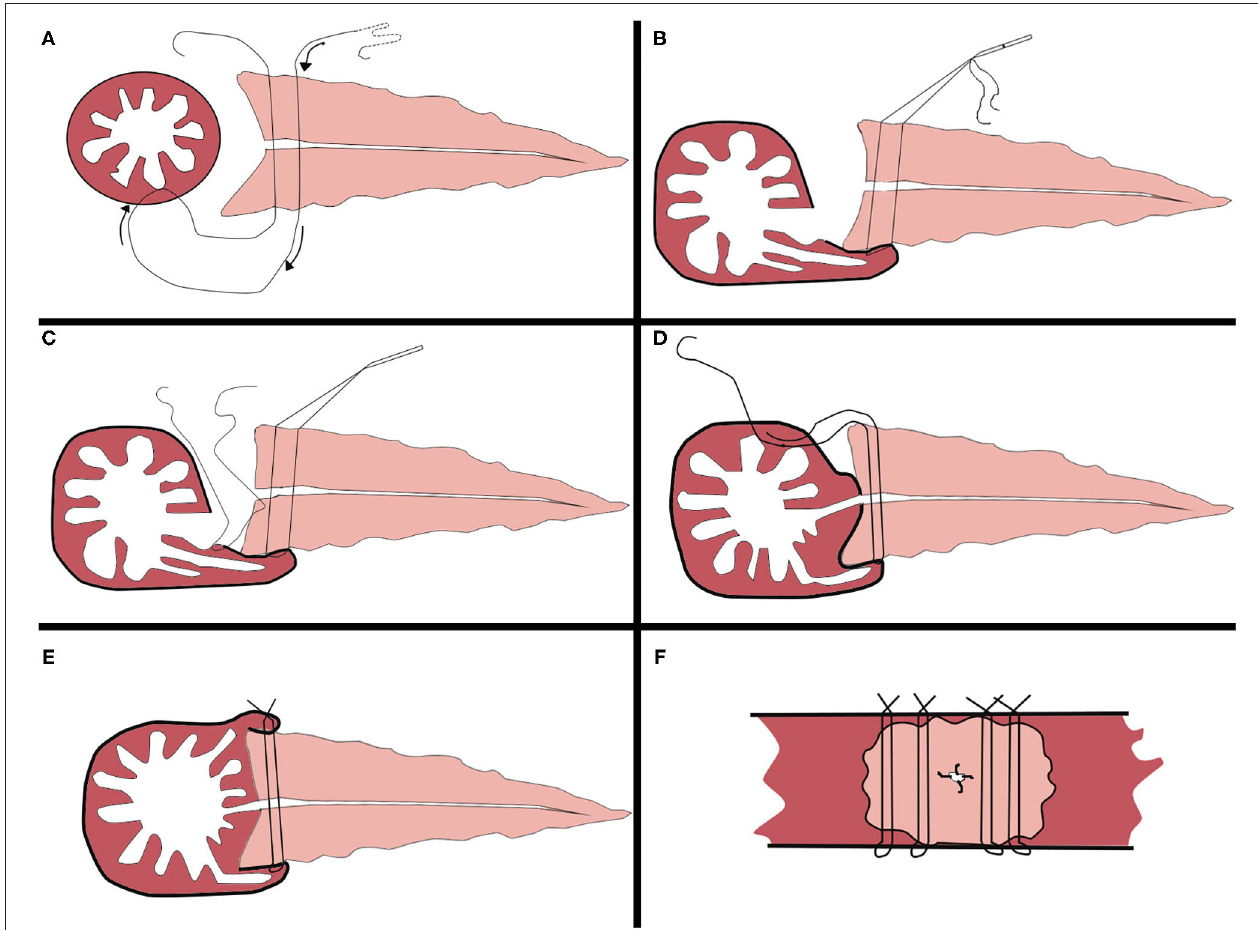
FIGURE 2 | Mode chart of the modified Blumgart pancreaticojejunostomy procedure. (A) Placement of four interrupted penetrating U-sutures with 3-0 proline, large needle. (B) Approximation of the jejunal seromuscular layer. (C) Duct-to-mucosa anastomosis with four interrupted 5-0 PDS. (D) Suturing of the anterior wall of the jejunal seromuscular layer. (E) Tying of the knots on the jejunum one by one, longitudinal view of the completed anastomosis. (F) Transverse view of the completed